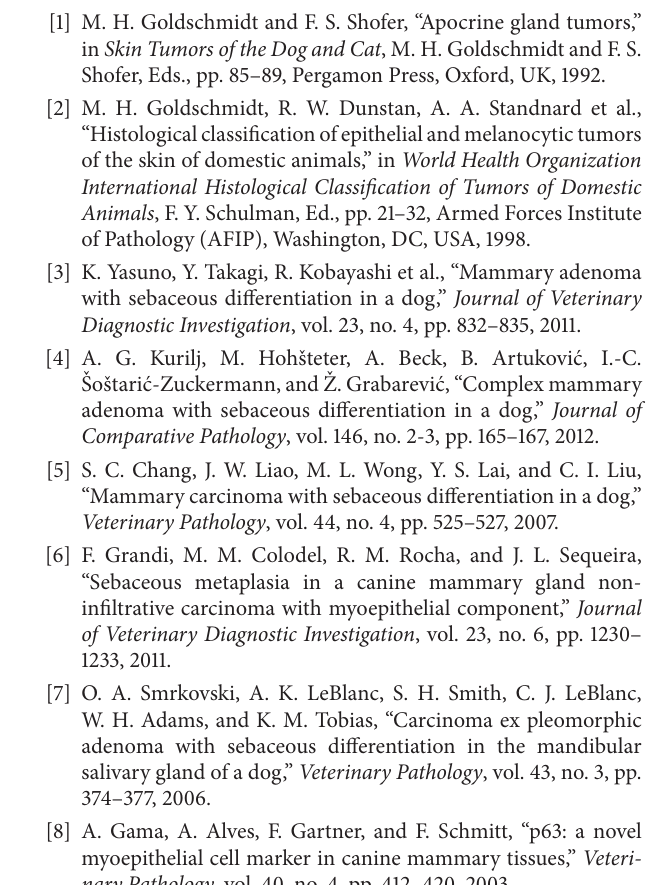
Figure4:Basaloidtumorcellsandcellsshowingsebaceousdifferen- tiation are positive for CK14. Immunohistochemistry for CK14 with hematoxylin counterstain. Bar = 50 𝜇 m.